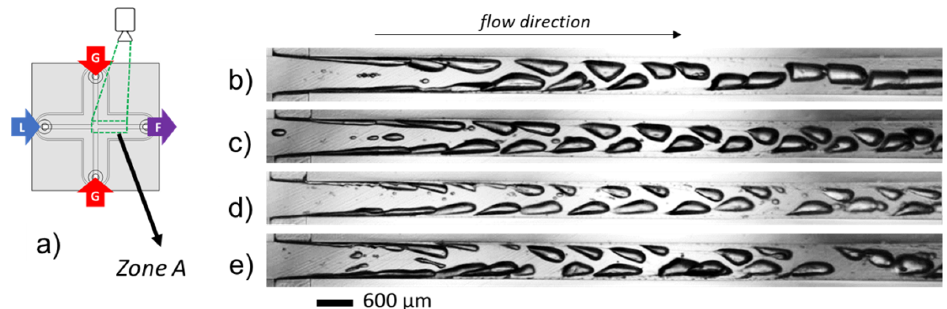
Figure 4. ( a ) Visualization at the area of bubble formation (Zone A) in the channel 600 × 600 µ m 2 of the device CX600. ( b – e ) Images at different process conditions: ( b ) Q vL = 11 L · h − 1 − Q mG = 21.6 g · h − 1 . ( c ) Q vL = 13.7 L·h −1 –Q mG = 26.5 g h −1 ( d ) Q vL = 16.4 L h −1 –Q mG = 31 g h −1 e) Q vL = 19 L h −1 –Q mG = 36.4 g ( c ) Q vL = 13.7 L · h − 1 − Q mG = 26.5 g · h − 1 . ( d ) Q vL = 16.4 L · h − 1 –Q mG = 31 g · h − 1 . ( e ) Q vL = 19 L · h − 1 h −1 ; liquid phase: model solution WPI3XG04, gas phase N 2 . Figure reproduced from [22] with per- − Q · h − 1 ; liquid phase: model solution WPI3XG04, gas phase N mG = 36.4 g 2 . Figure reproduced mission from Elsevier. from [22] with permission from Table 2. Hydrodynamic parameters of the two-phase flow in the mixing channel of the microfluidic device CX600 for several flow conditions using the model solution WPI3XG04.